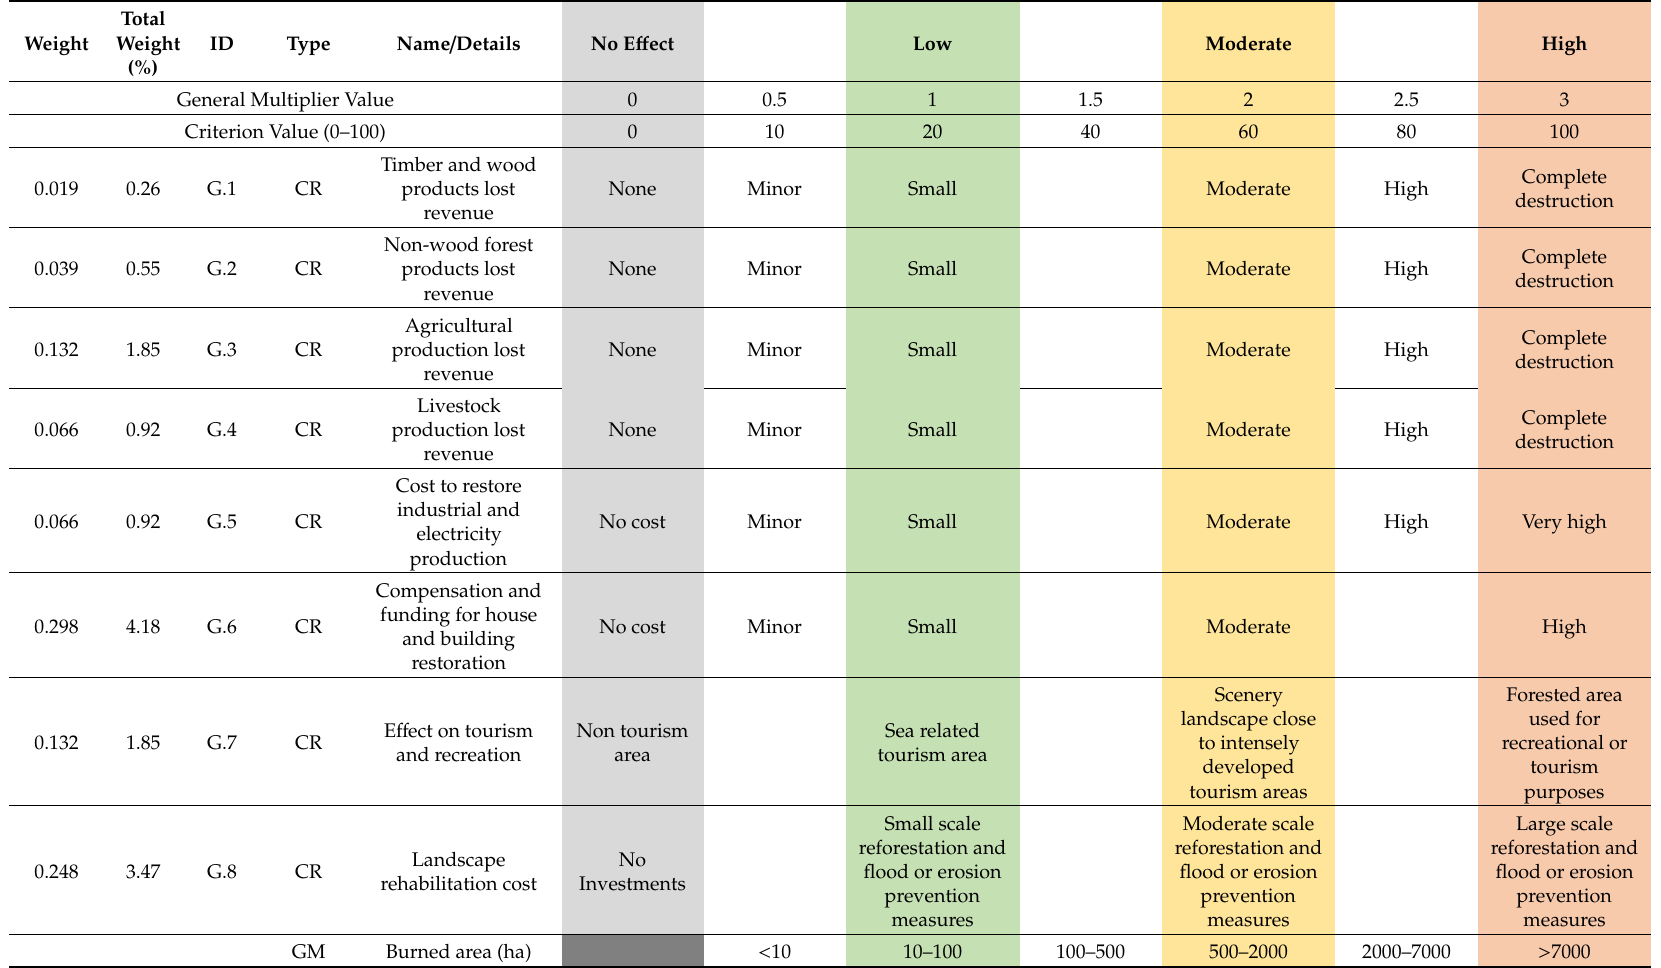
Table A7. Criteria, choices, and weights for the economic losses, compensation, and revenue losses fire e ff ects category. CR: criterion; GM: general multiplier. Light gray: Choices with no e ff ect; Dark gray: N / a, denotes a non-applicable or not available selection; Green: Choices with low e ff ect; Yellow: Choices with moderate e ff ect; Red: Choices with high e ff